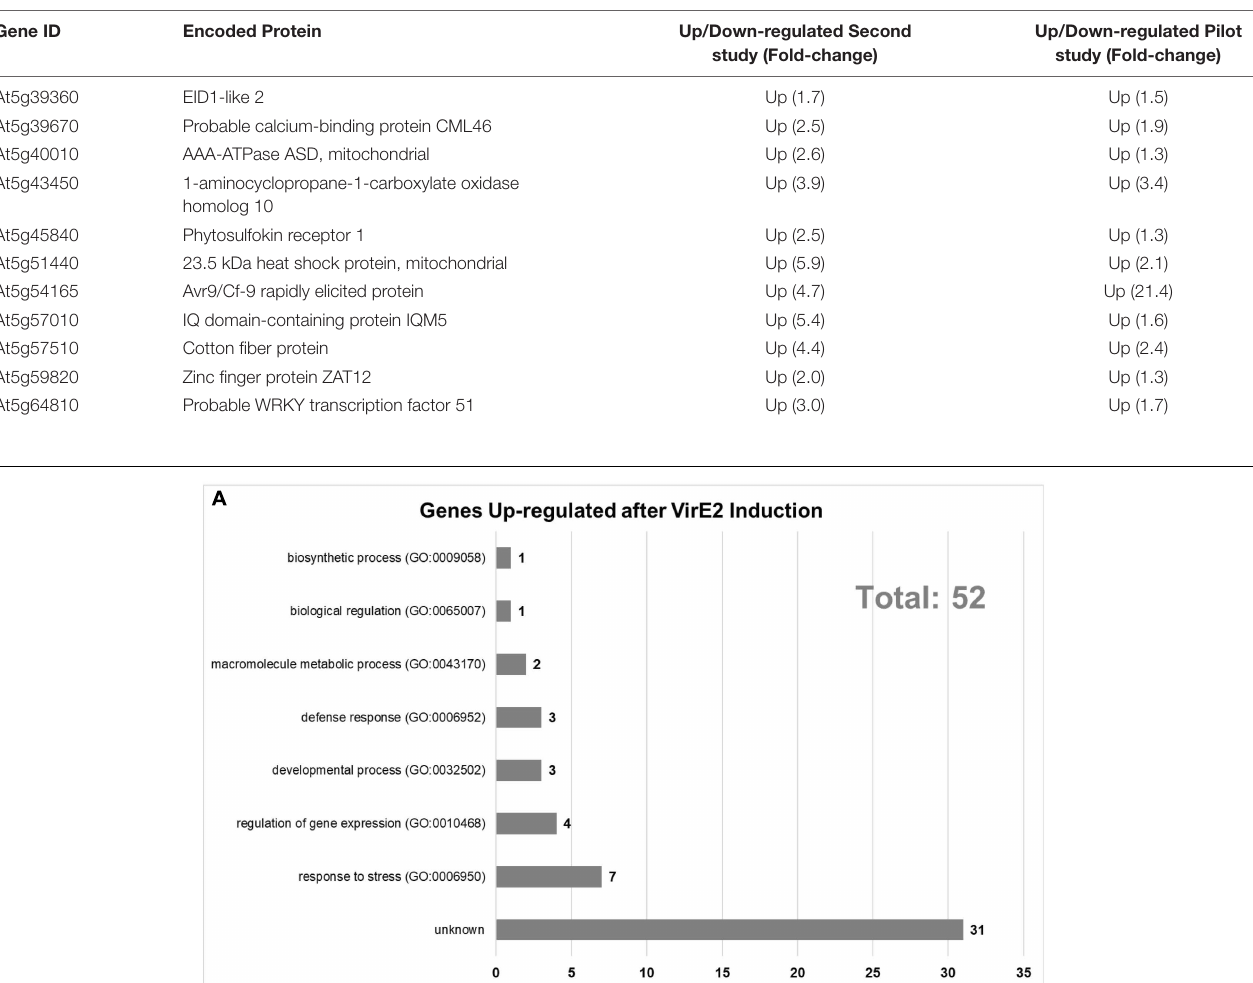
Frontiers in Plant Science |